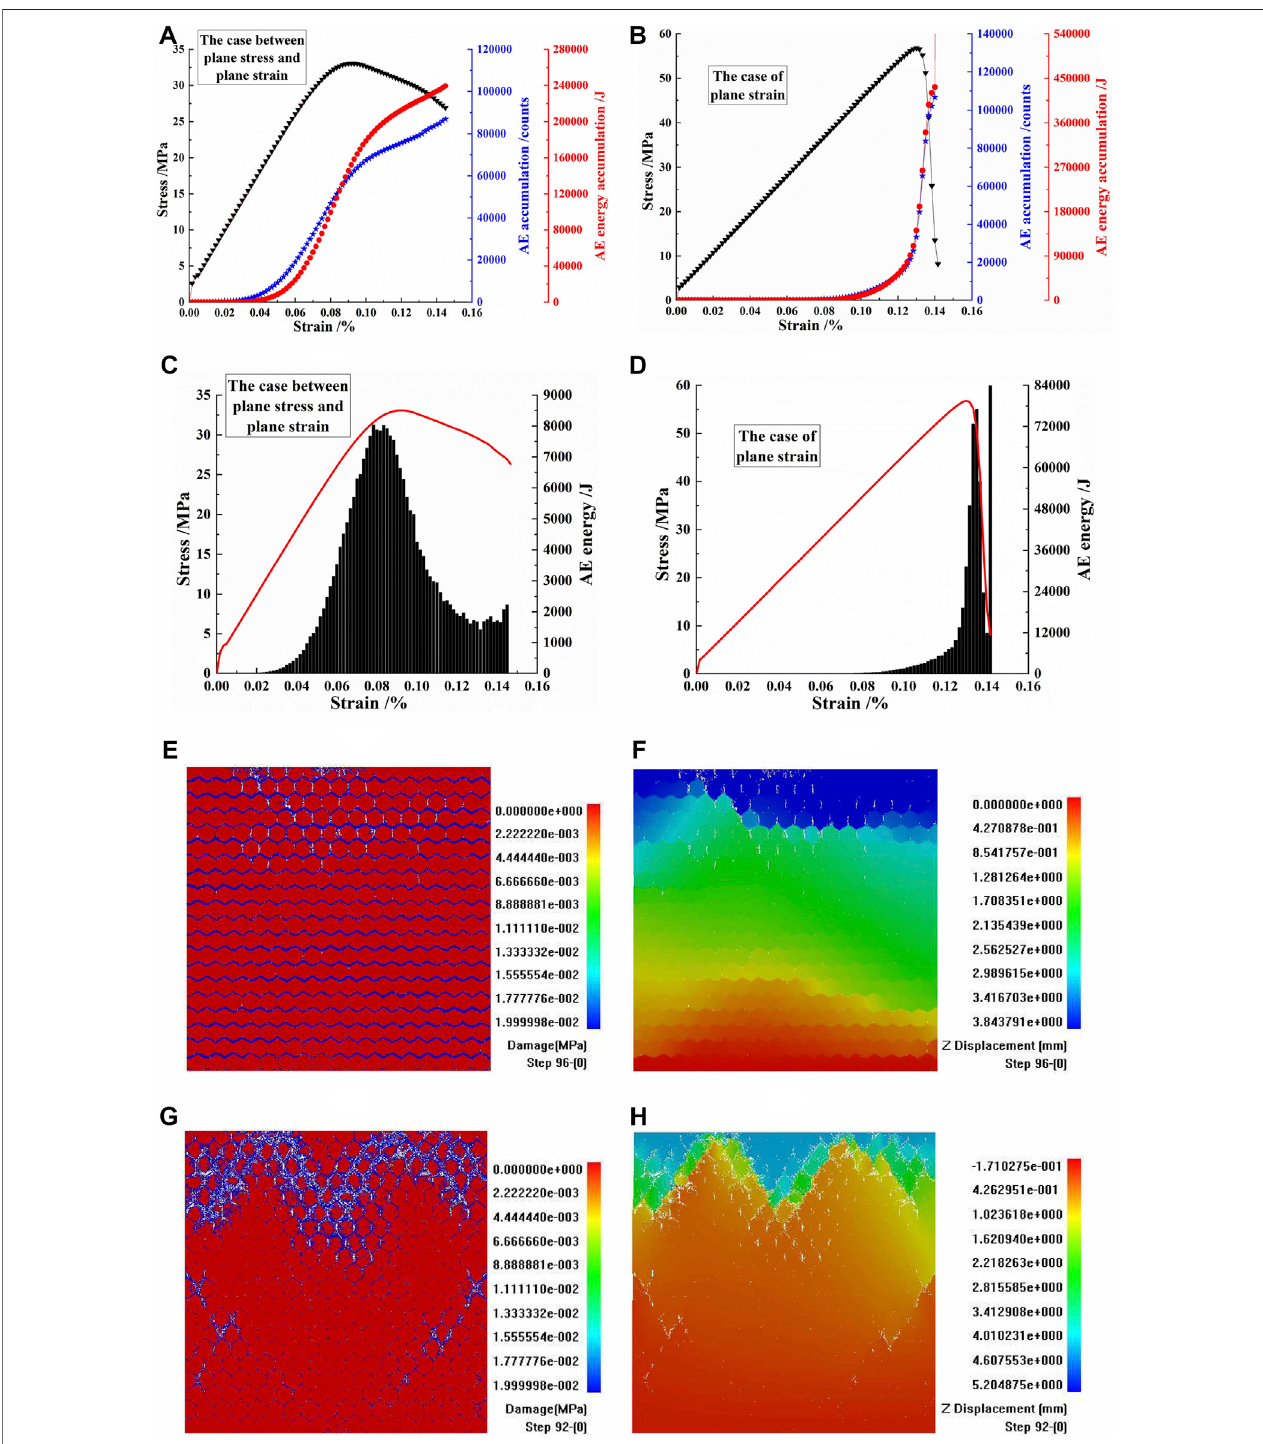
FIGURE10| (A,B) The stress – strain curves, acoustic emission (AE) accumulations, and AEenergy accumulations ofcolumnar jointed basalts (CJBs)in direction II orthogonaltothecolumnaxisforthecasebetweenplanestressandplanestrainandthecaseofplanestrain,withacon fi ningpressureof8 MPa. (C,D) Thestress – strain curves and AE energies of CJBs for the case between plane stress and plane strain and the case of plane strain. (E,F) Damage and displacement diagrams for the case between plane stress and plane strain. (G,H) Damage and displacement diagrams for the case of plane strain.